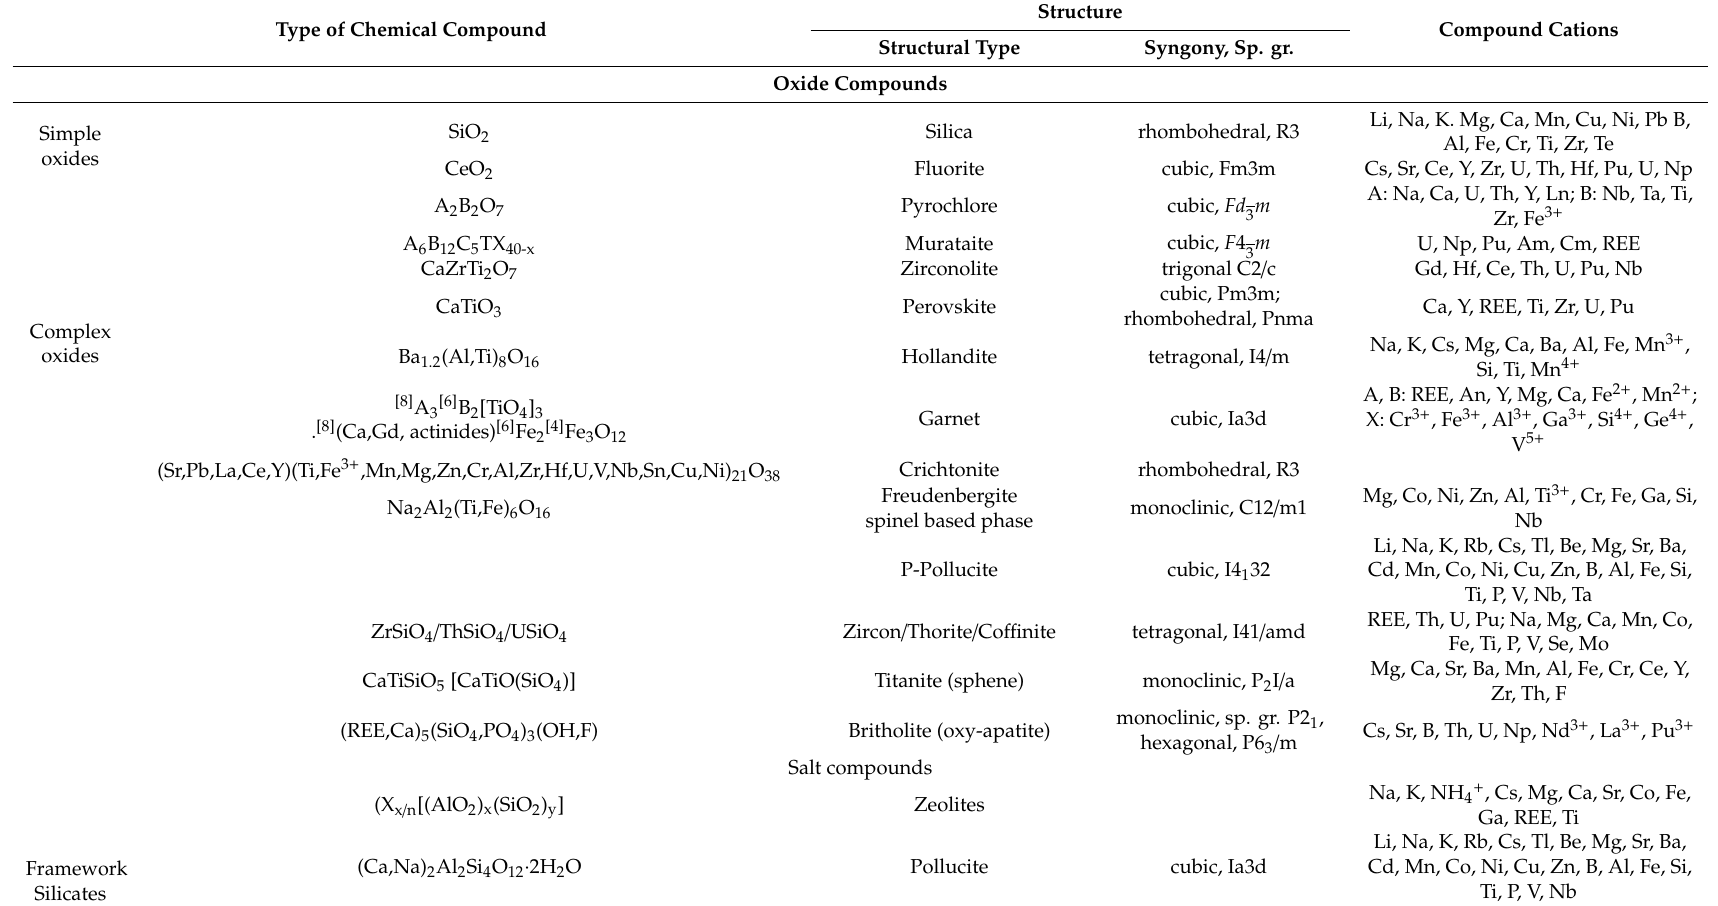
Table 1. Crystalline ceramic materials as potential forms for nuclear waste